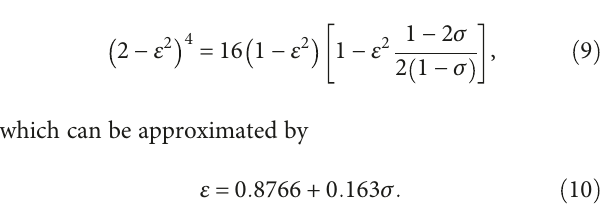
, S , and S with normal distributions and (b) samples S n1 n2 n3